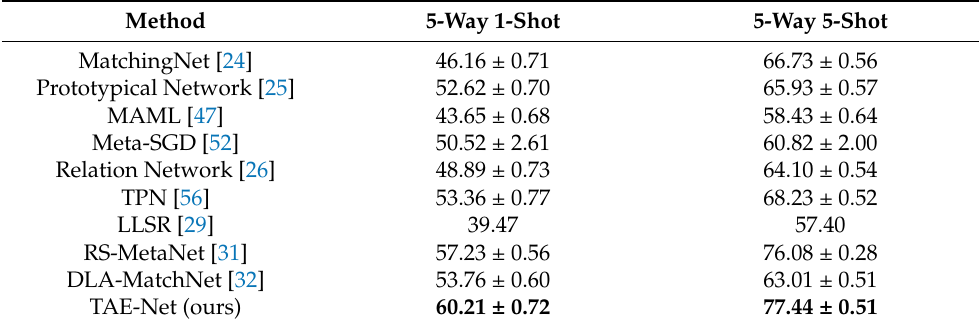
Table 2. Classification accuracies and standard deviations (%) of 5-way 1-shot and 5-way 5-shot on the UC Merced dataset. The best results per scenario are marked in bold.